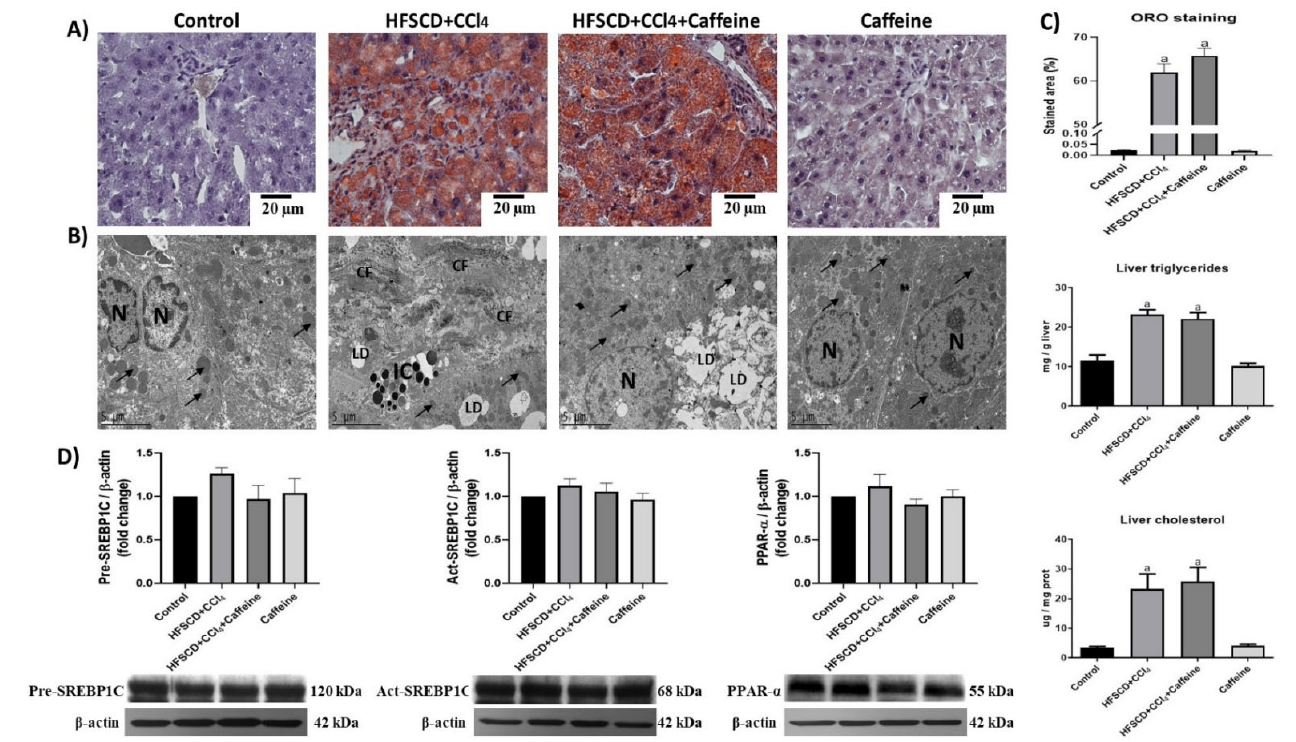
Figure 2. Effect of caffeine on steatosis markers and ultrastructure anatomy of hepatic tissue from the NASH model. ( A ) ORO staining of hepatic tissues from rats in the control, HFSCD+CCl 4 , HFSCD+CCl 4 +caffeine, and caffeine groups. Scale bar = 20 µ m. ( B ) Transmission electron micro- graphs of hepatic sections. Scale bar = 2 µ m. (Arrow) mitochondria, (CF) collagen fibers, (IC) inflammatory cell, (LD) lipid drop, (N) nucleus. ( C ) Percentage of labeled area stained with ORO. Bars represent the mean of experiments performed in duplicate ± SEM (n = 4), liver triglycerides, and cholesterol. Bars represent the mean of experiments performed in duplicate ± SEM (n = 5). ( D ) Western blot analysis of precursor-sterol regulatory element-binding protein 1C (pre-SREBP1C), active-SREBP1C (act-SREBP1C), and peroxisome proliferator-activated receptors alpha (PPAR- α ) proteins. Bars represent the mean of experiments performed in duplicate ± SEM (n = 3); β -actin was used as a loading control. (a) p < 0.05 compared with the control